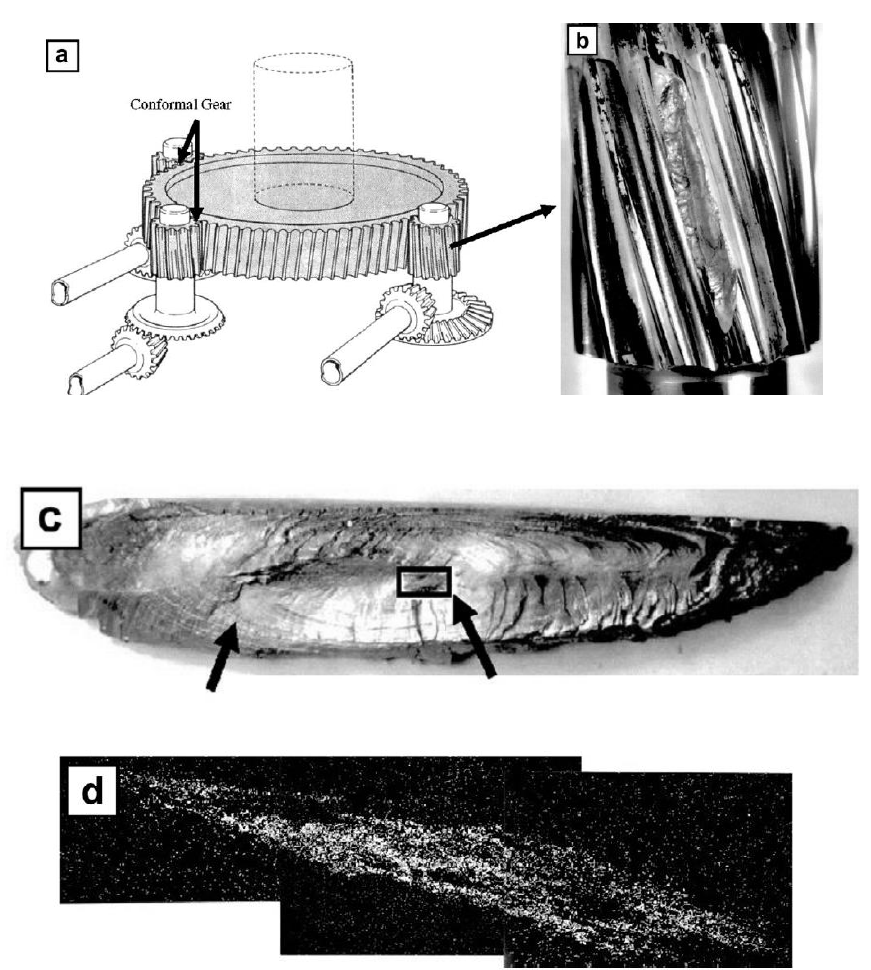
Figure 9. The details of an in-service failure of a steel helicopter conformal gear: ( a ) the gear assembly, ( b ) the gear that failed due to fatigue, ( c ) analysis of the fracture surface, showing the fatigue crack initiation site (boxed) and striations, and ( d ) X-ray map showing the presence of oxygen at the crack initiation site Reprinted with permission from ref. [52]. Copyright 2022 Elsevier